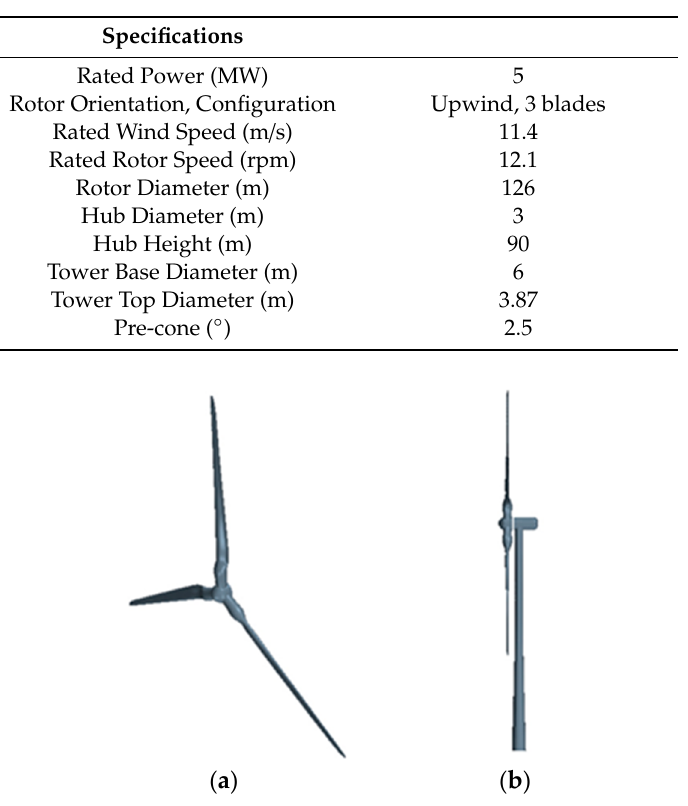
Table 5. Principal dimensions of the NREL 5 MW reference wind turbine.